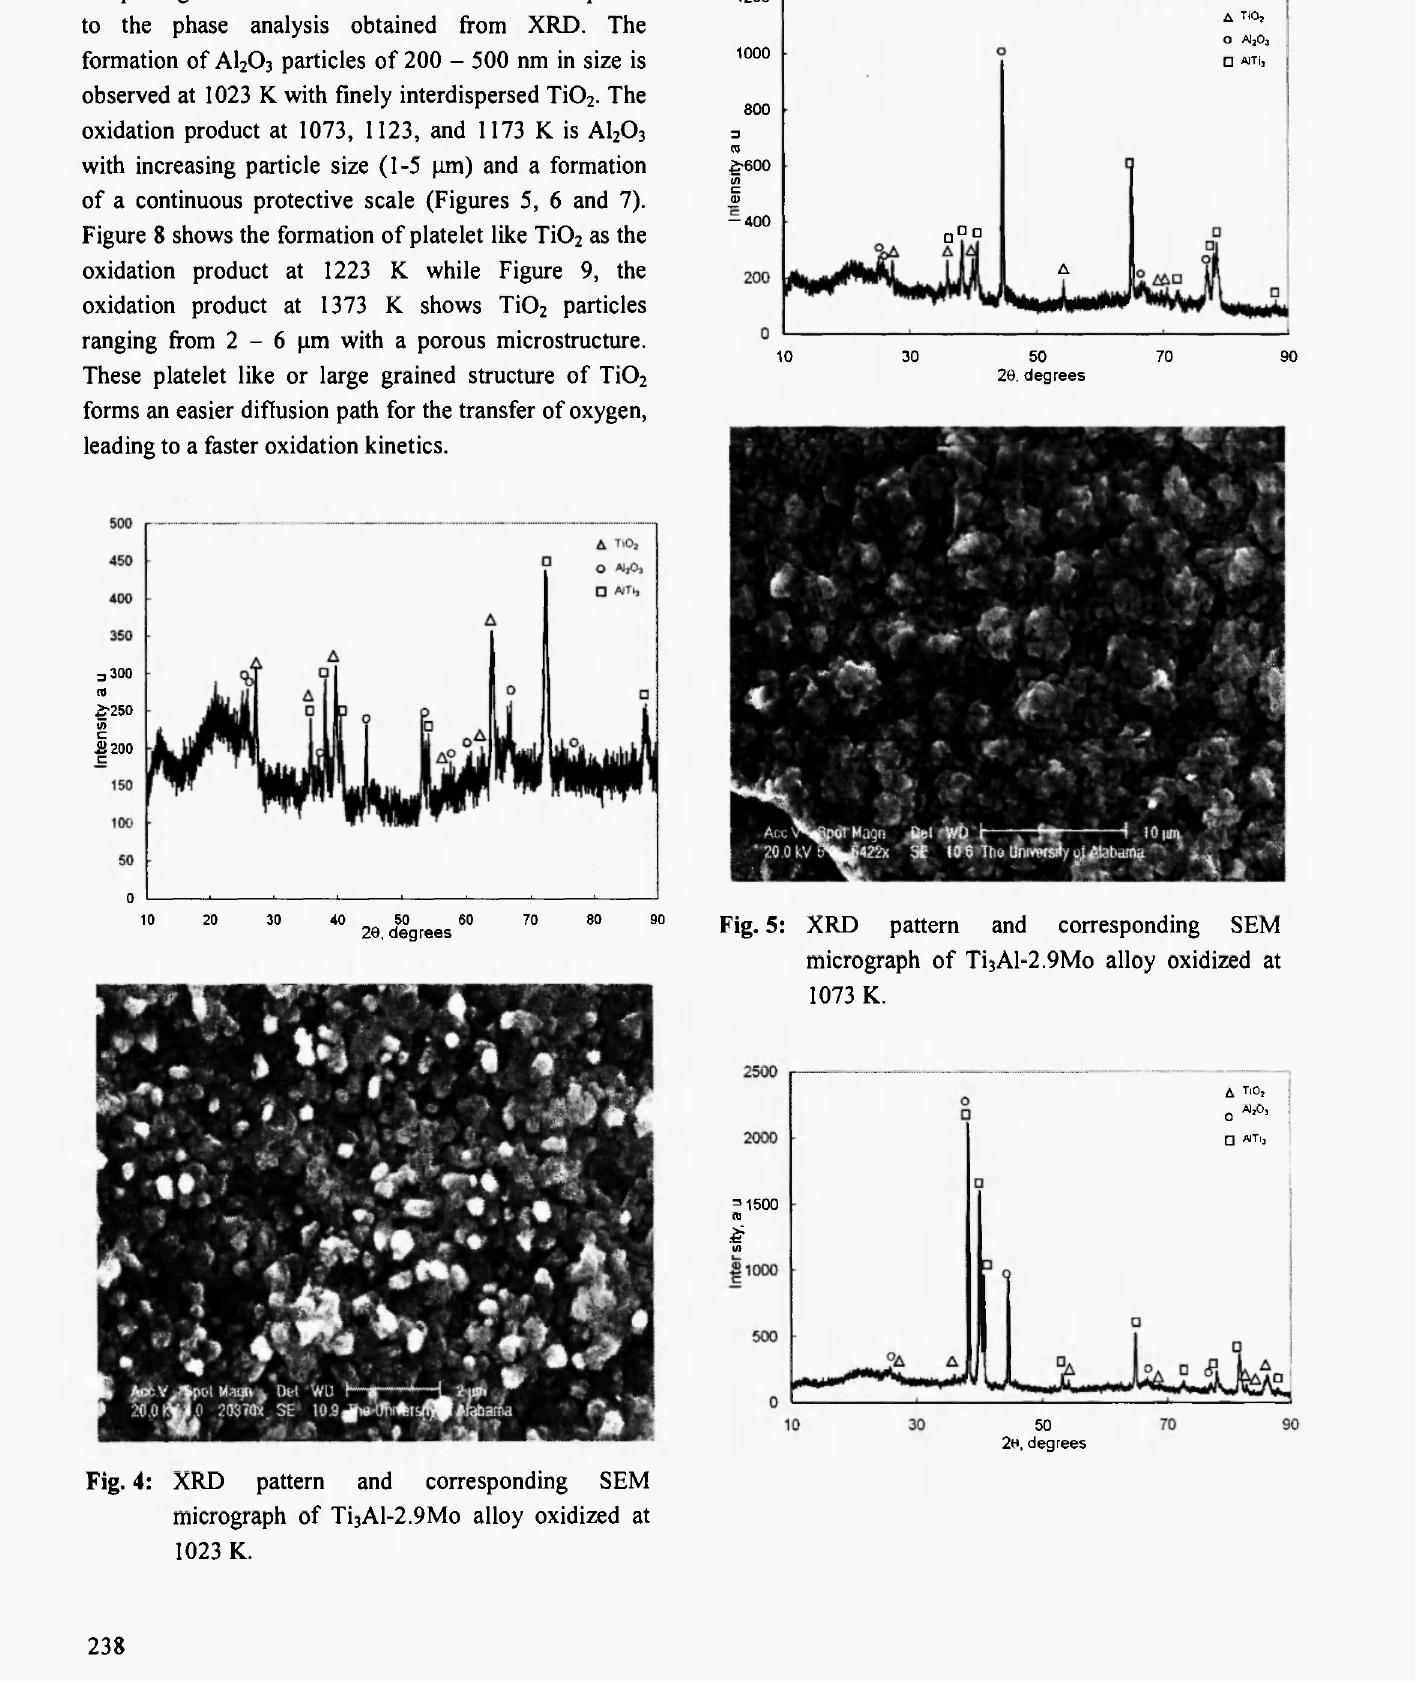
Fig. 4: XRD pattern and corresponding SEM micrograph of Ti 3 Al-2.9Mo alloy oxidized at 1023 K.